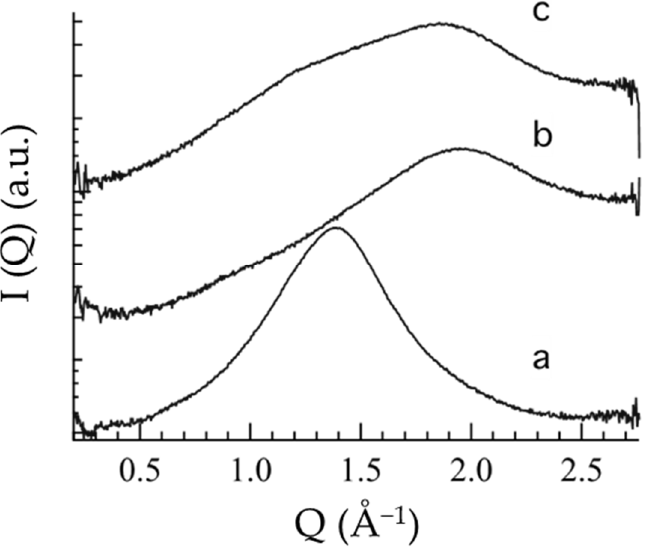
Figure 3. Wide-angle X-ray scattering profiles of OG ( a ), POL ( b ) and POG ( c ). To prepare OG-QT and OG-MG, the drugs were solubilized in the lipophilic phase constituted of PC/IPP before the addition of water, reaching 0.8 and 0.7 mg/mL for QT and MG, respectively. Conversely, the production of both the hydrophilic gels (POL-QT and POL-MG) and the biphasic systems (POG-QT and POG-MG) was achieved by drug solubilization in the preformed P407 aqueous solution. Notably, the micellar structure formed by the block co-polymer allowed solubilization of the lipophilic QT and MG up to 2.8 and 1.7 mg/mL (log P values 1.82 and 0.53, respectively) [20,46,47]. It is to be underlined that the loading of QT in POL enabled dramatic improvement of the polyphenol solubility with respect to water (being 0.00215 mg/mL at 25 ◦ C) [48]. However, in all cases,